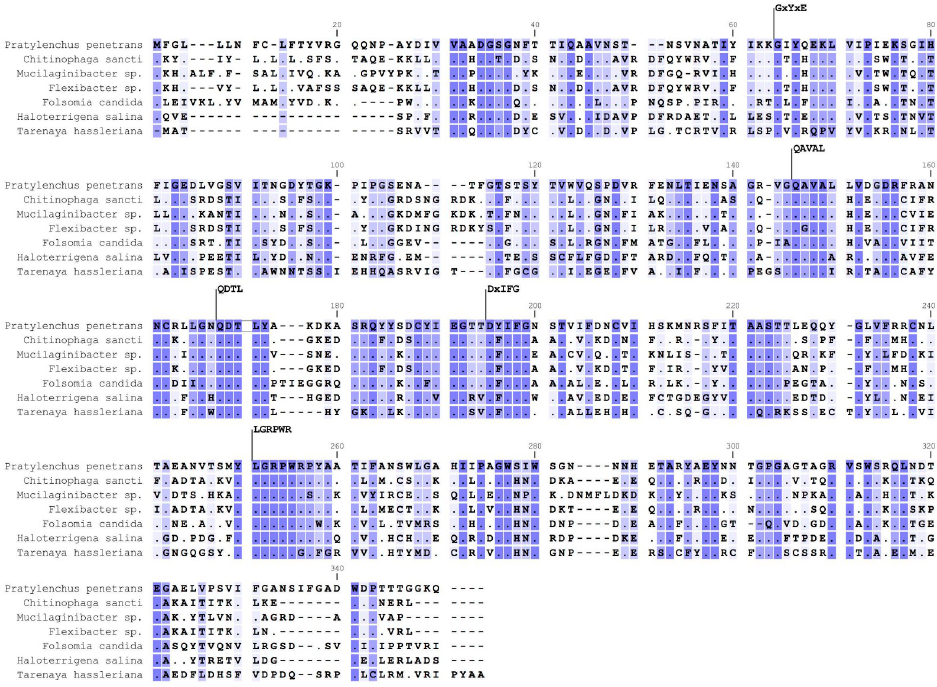
Fig 2. Multiple sequence alignment of the predicted Pp-PME protein of Pratylenchus penetrans with PMEs of other organisms. Representative species of bacteria ( Chitinophaga sancti , Mucilaginibacter sp., Flexibacter sp.), collembolan ( Folsomia candida ), Archaea ( Haloterrigena salina ) and plants ( Tarenaya hassleriana ) were used. The five conserved sequence segments typical of PME proteins are numbered according to their positions in the corresponding Pp-PME predicted protein (64_GxYxE, 146_QAVAL, 168_QDTL, 195_DxIFG, and 251_LGRPW). Conserved residues among species are indicated by dark blue shading and dots, whereas similar residues are represented in light blue using a threshold for shading of 50% similarity. The accession numbers corresponding to each species are presented in S3 Table.